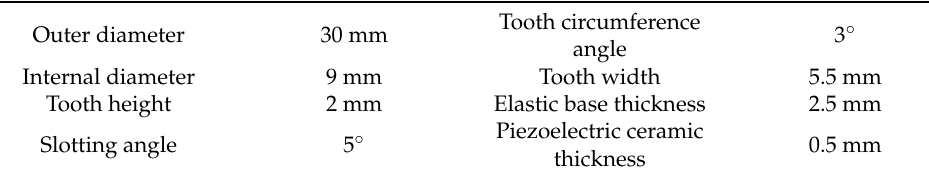
Table 1. Motor stator structure size parameters.